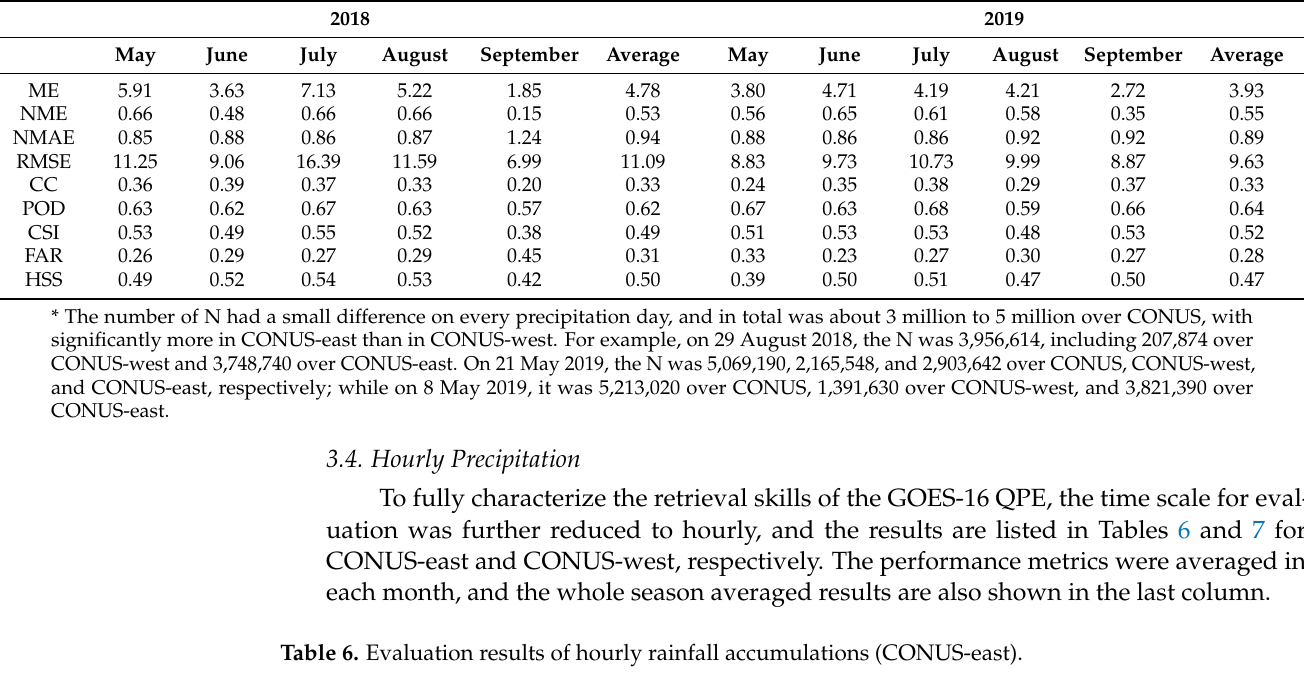
Table 5. Evaluation results of daily rainfall accumulations (CONUS-west *).